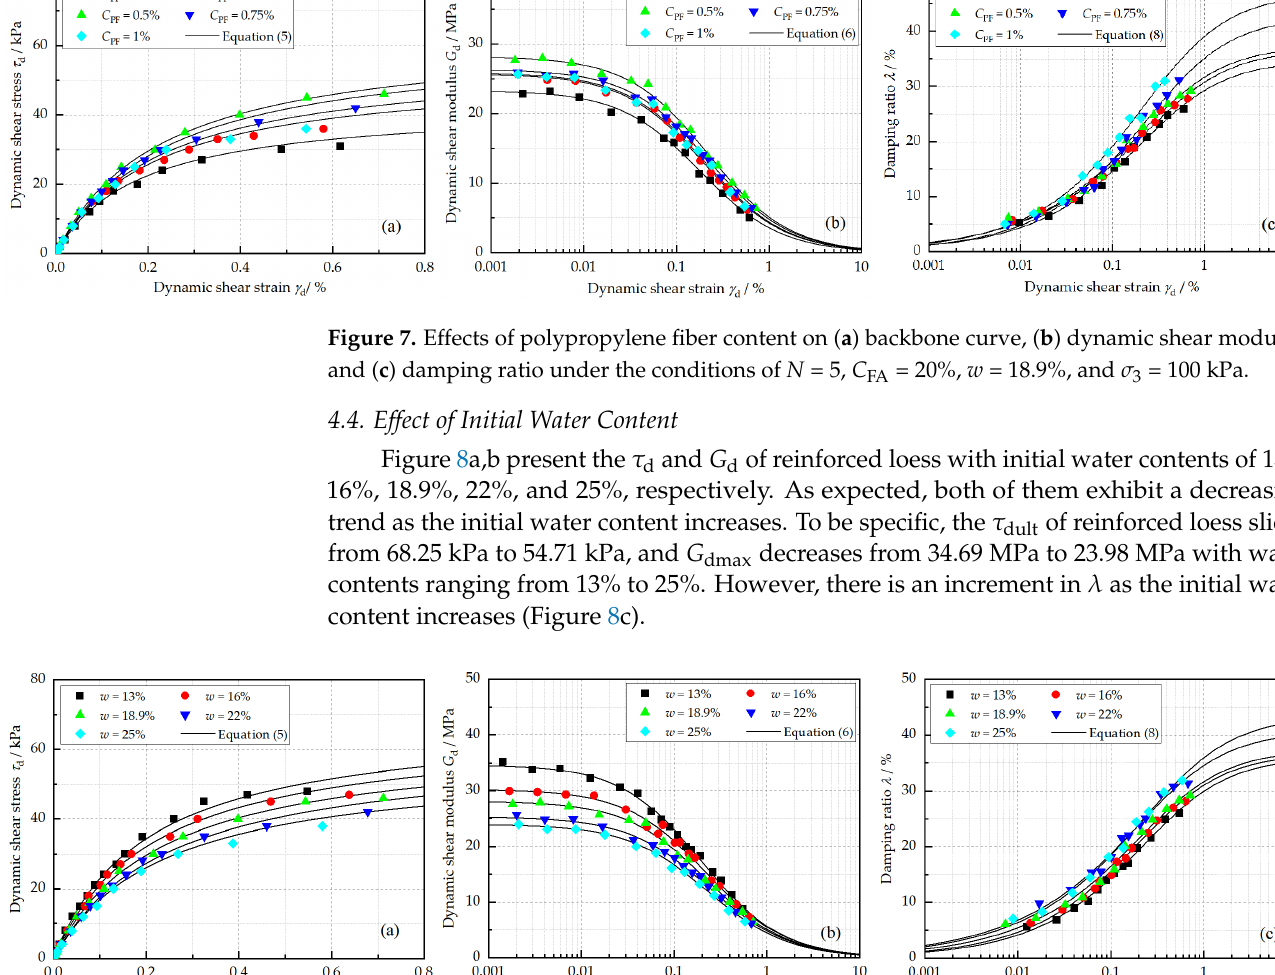
C = 20%, C = 0.5%, and σ = 100 kPa. FA PF 3